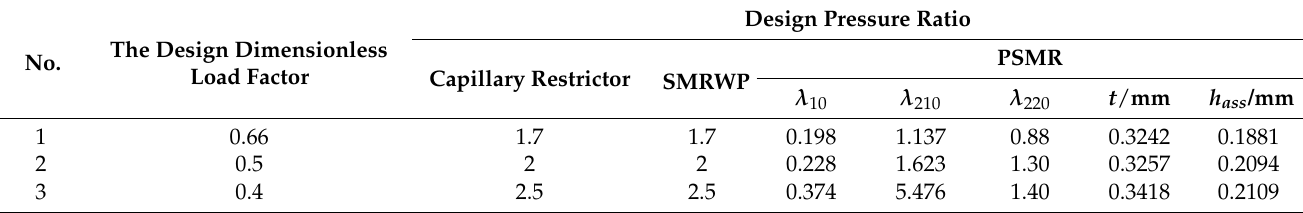
Table 4. Table of design parameters.